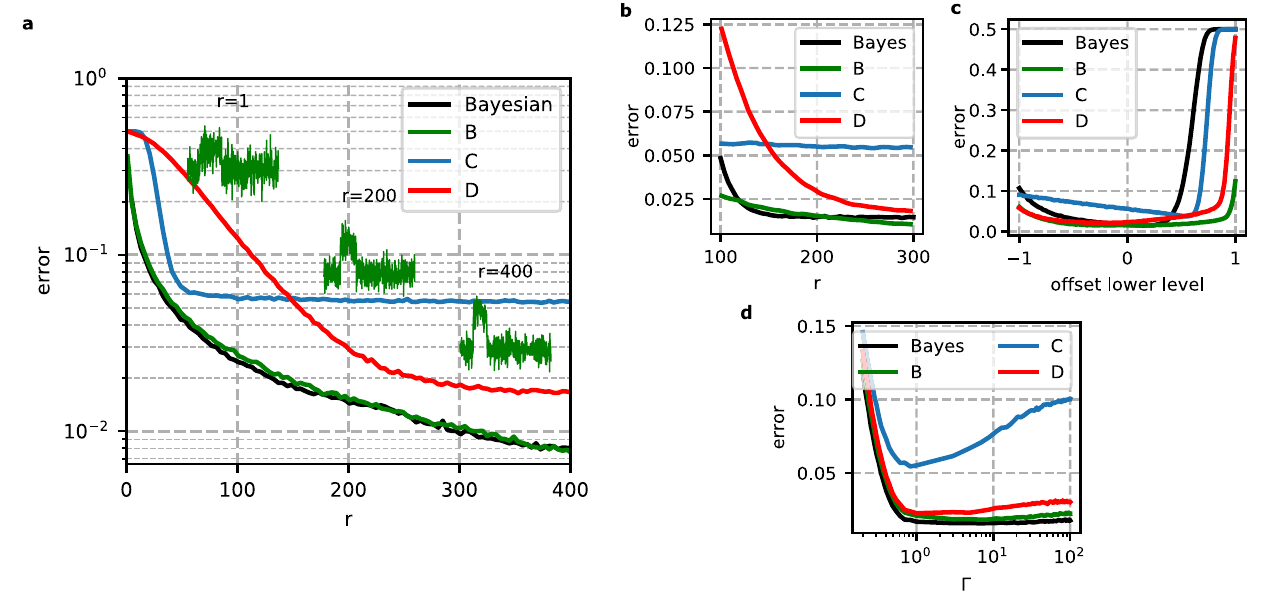
Figure 2. ( a ) Classification error of the neural network B , trained with synthetic |↑� and |↓� traces, compared to classification by the Bayesian inference filter, considering Gaussian noise, Ŵ = 1 and various r . The network C is trained on meausured data and network D is trained with synthetic traces superimposed with typical noise from the experimental setup. The green inset traces are example input traces for |↑� -events at a given r . ( b – d ) Robustness of the Bayesian inference filter and the neural networks B , C and D to three parameters of synthesized traces superimposed by Gaussian noise. ( b ) Robustness to the SNR r variations. ( c ) Robustness to an offset of the low-current level of I SET . The x-axis here indicates the deviation of the lower level from the value of − 1. ( d ) Robustness to variations in the tunnel rates Ŵ